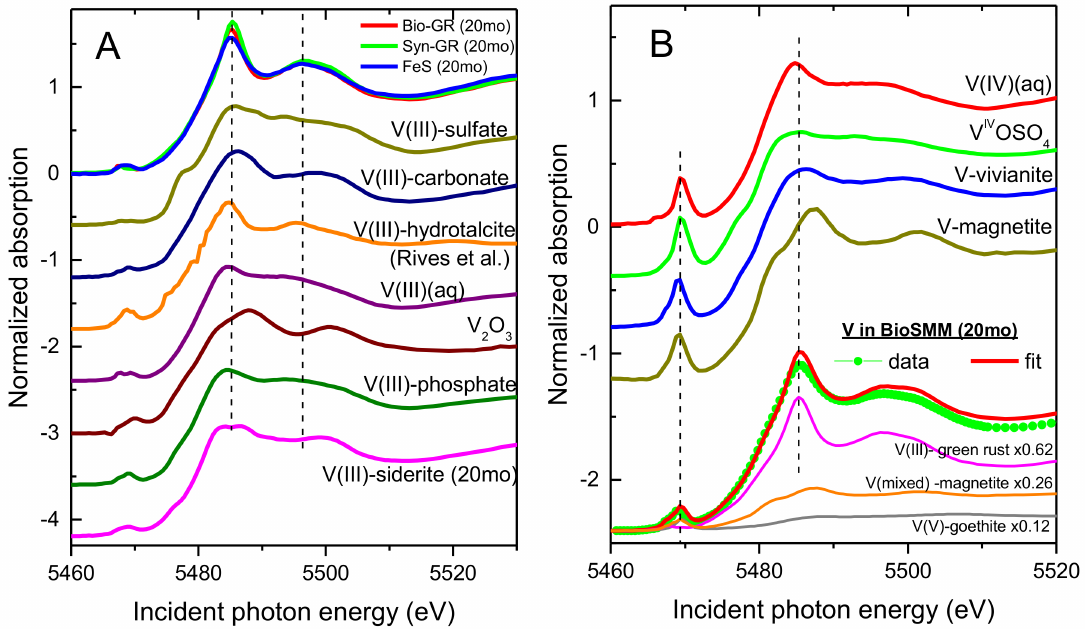
Figure 11. ( A ) Comparison of the spectra from the final V(III) species in the green rust and FeS reactors to the available V(III) standards. The vertical dashed lines indicate features discussed in the text. The data for the V(III)-hydrotalcite spectrum was digitized from Figure 2 of Rives et al. [108]. The V(III) species in the siderite system after 20 months are shown at the bottom. ( B ) The spectra of the intermediate V valence species in the vivianite and magnetite systems are compared to the V(IV) standards at the top. The bottom spectra present the linear combination analysis of the V species in the BioSMM system after 20 months. The scaled best fit components that combine to produce the fit line are also